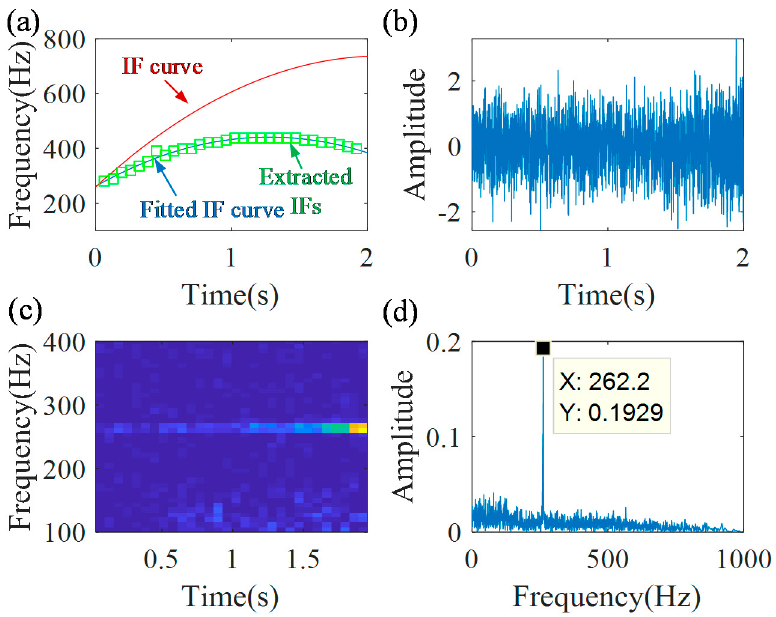
Figure 6. Second demodulation results: ( a ) extracted IFs; ( b ) second demodulated signal; ( c ) TFR of second demodulated signal; and ( d ) the spectrum.